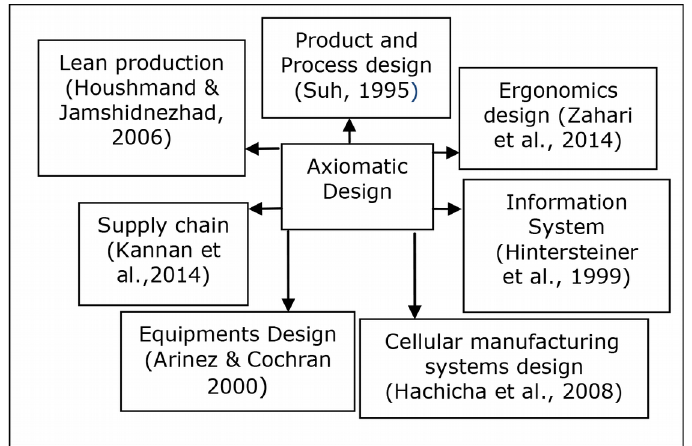
Figure 1. The domains of axiomatic design application in manufacturing